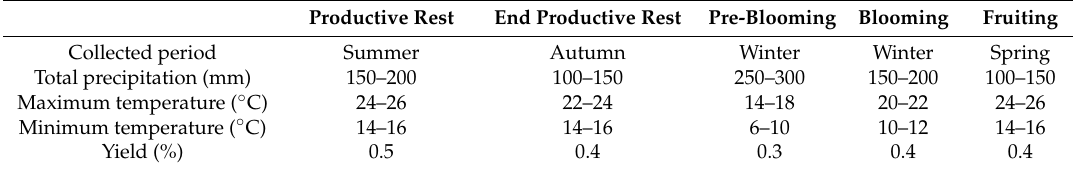
Table 1. Climatic characteristics and yield of Nectandra megapotamica essential oils during each collection